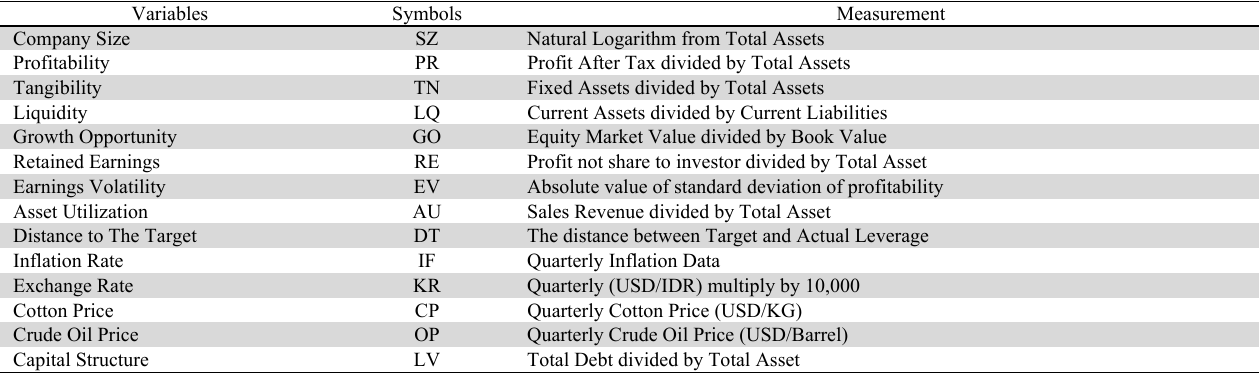
The Variable and